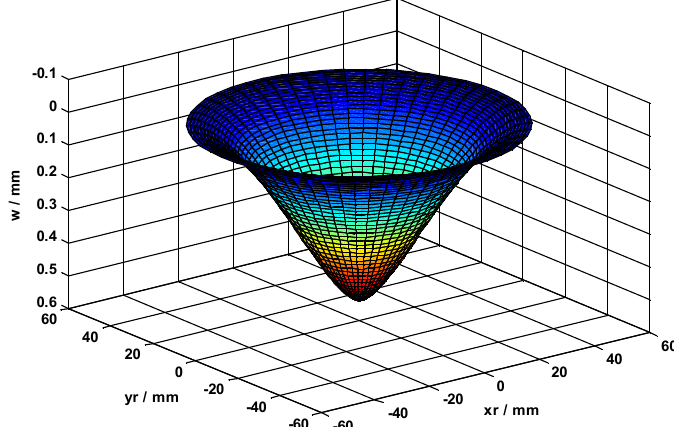
Figure 7. Deflection of the circular thin plate.